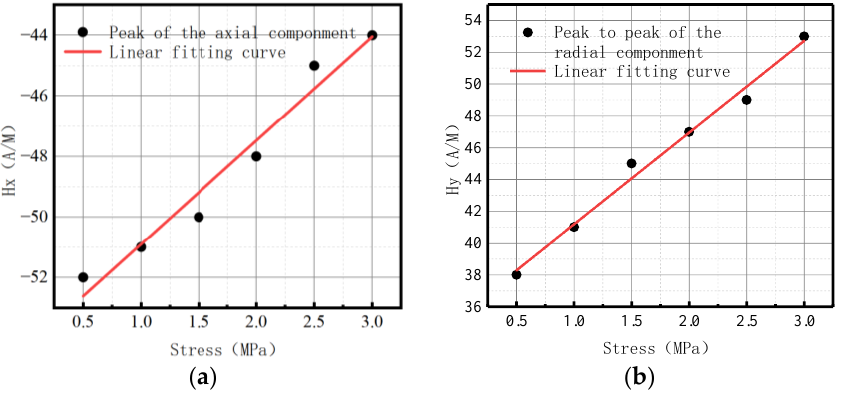
Figure 31. Peak value varies at weld crack with internal pressures. ( a ) Peak values of the axial component; ( b ) peak-to-peak values of the radial component.